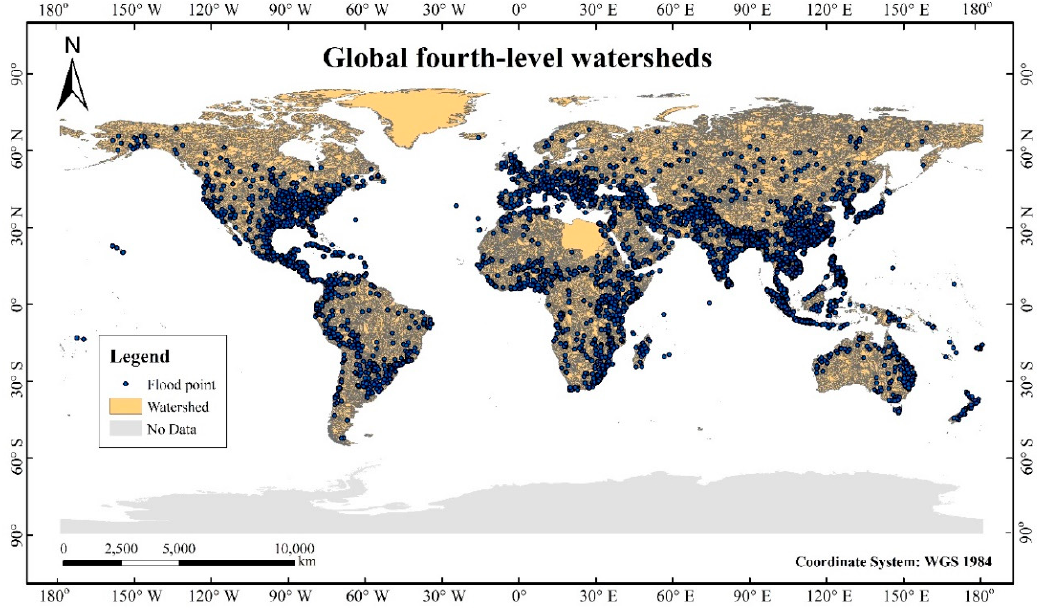
Figure 1. Global fourth-level watersheds and the location of flood inventories.